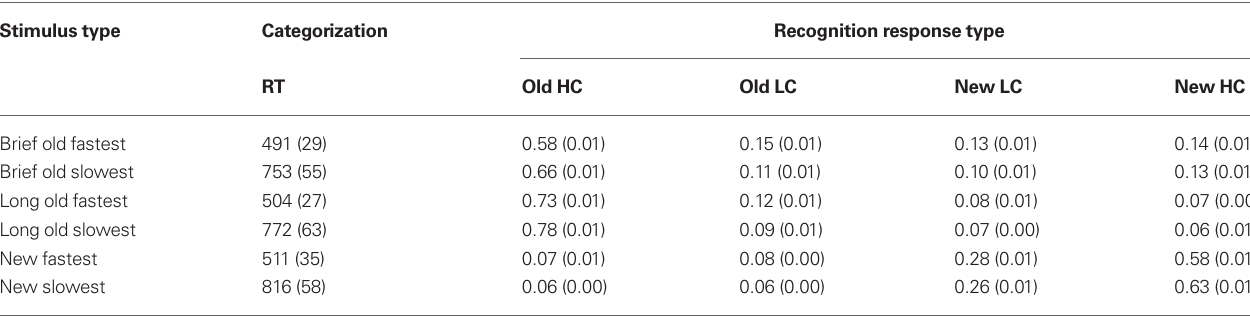
Table 2 | Mean recognition endorsement rates for high confidence and low confidence responses computed as a function of response time (rT) on the priming measure (in